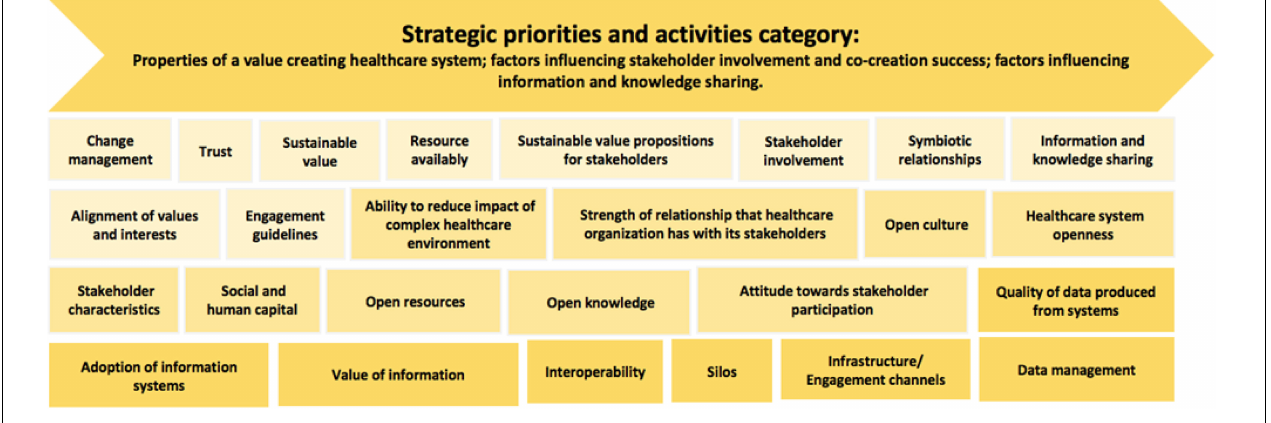
FIGURE 14 | Recommended strategies and activities to